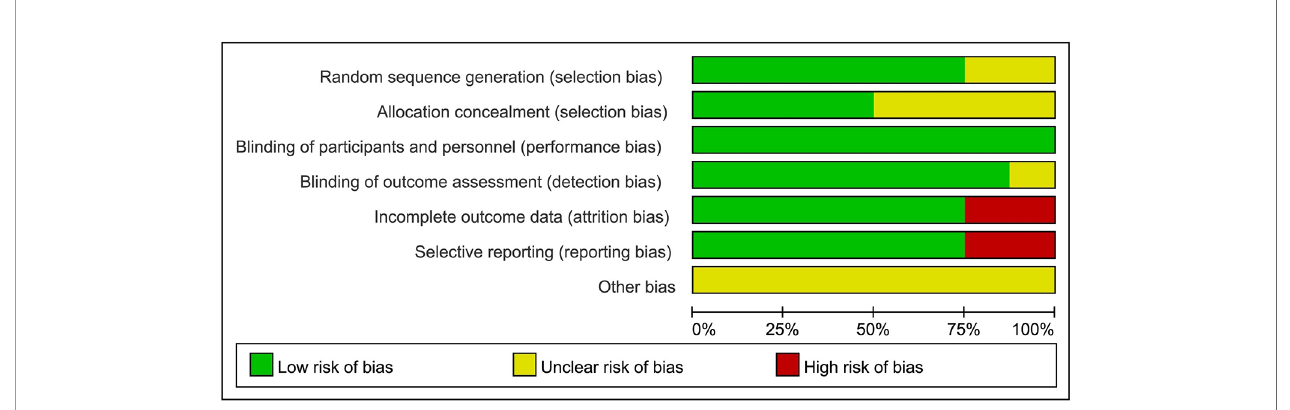
FIGURE 6 | Quality of including studies in the meta-analysis.